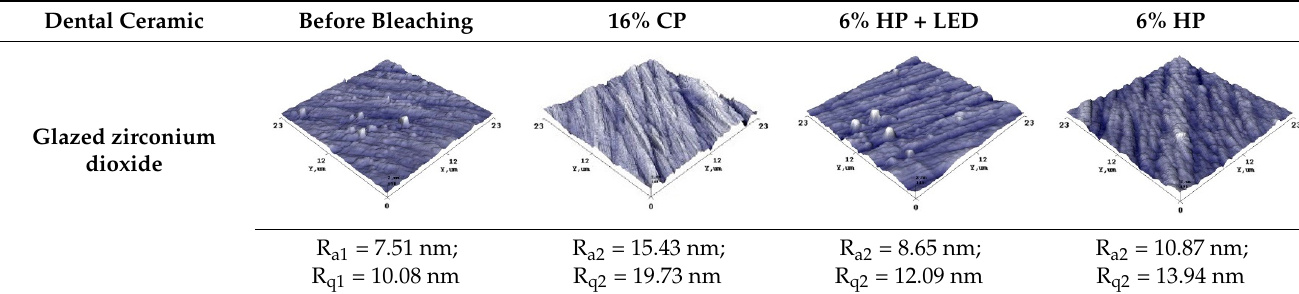
Table 3. Mean surface roughness values of dental ceramics before and after bleaching with different bleaching agents.